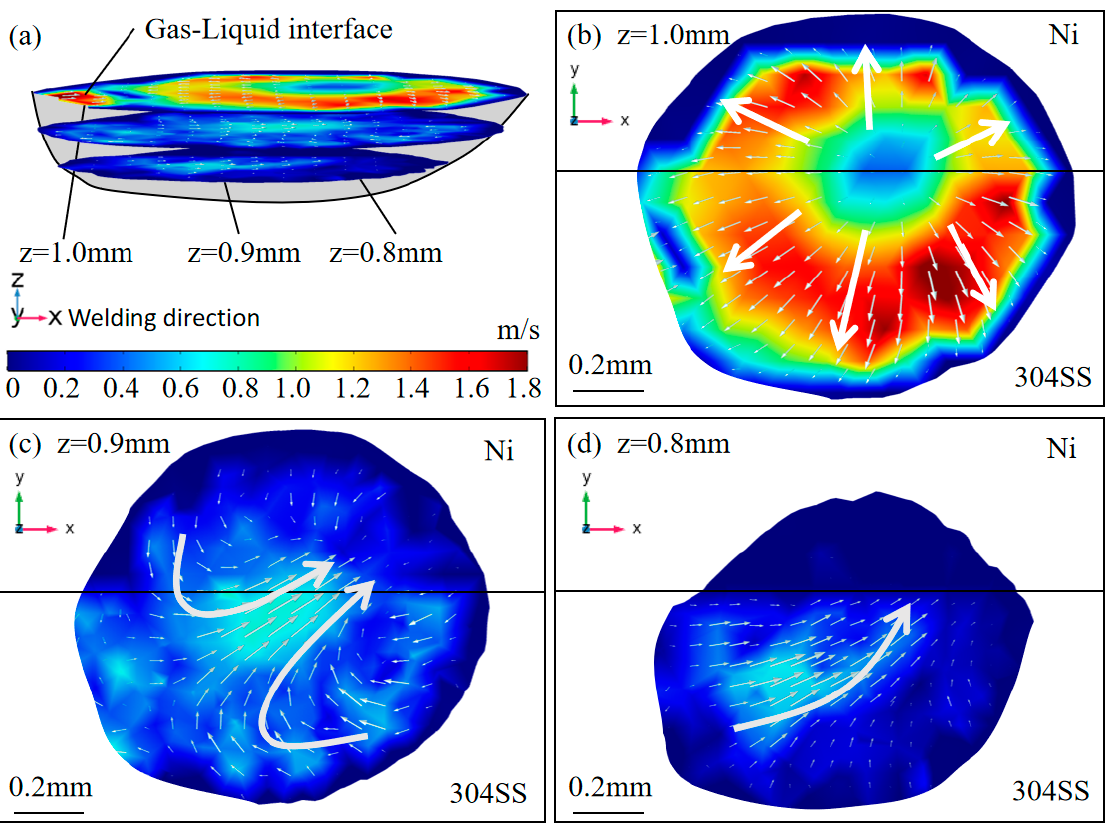
Figure 13. Fluid flow of the molten pool in pure argon for different X–Y sections. ( a ) Overview of sections in the molten pool: ( b ) z = 1.0 mm; ( c ) z= 0.9 mm; ( d ) z = 0.8 mm.